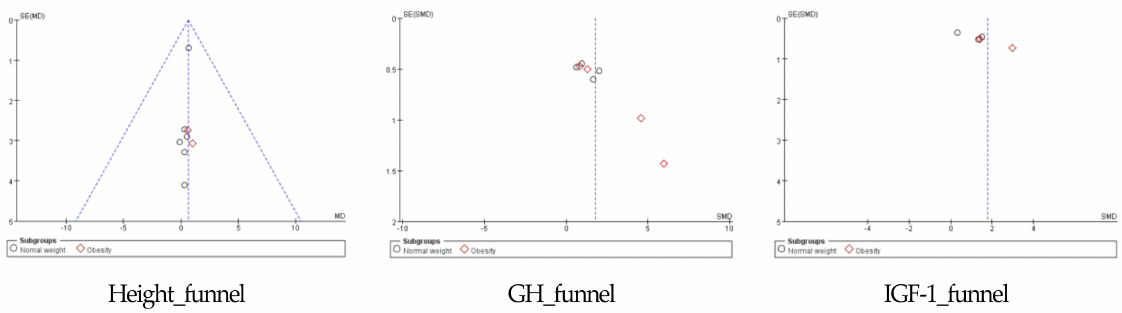
Figure 6. Funnel plot. GH: growth hormone and IGF-1: insulin-like growth